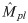
Data set M vs. v6M (or 10−2
D) and the model outputs M^pl for overall patients’ population.